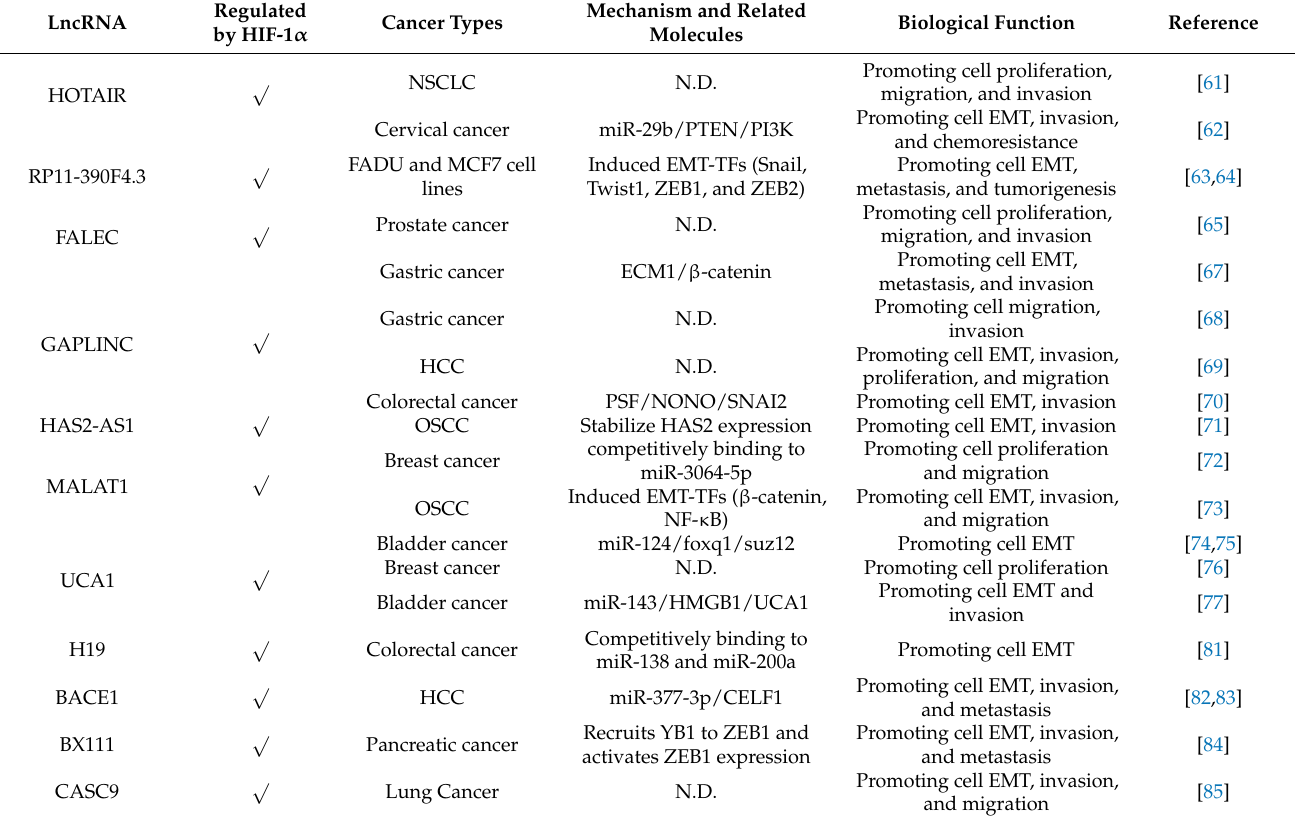
Table A1. Summary of LncRNAs regulated by HIF-1 α that promote EMT in tumor